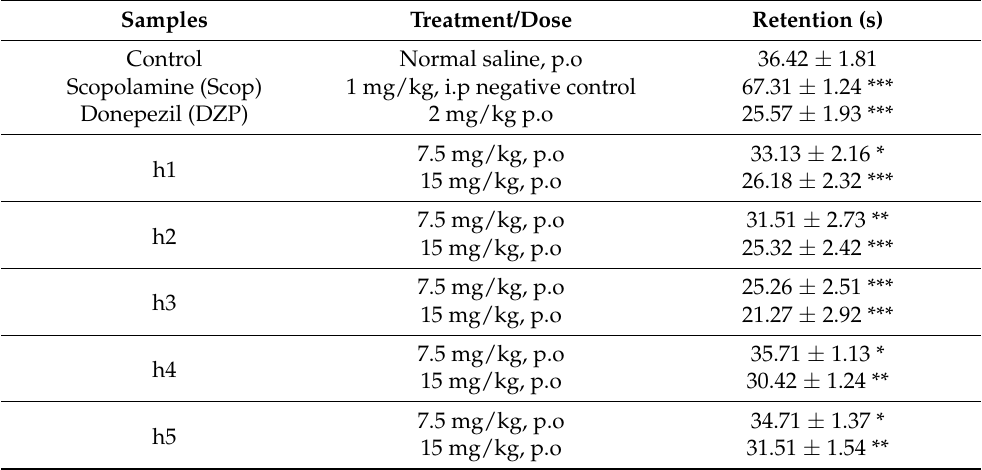
Table 3. Effect of synthesized curcumin analogs h1 – h5 on alteration behavior and transfer latency in